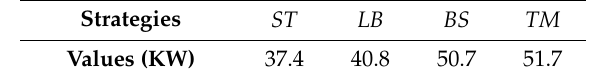
Table 5. Values of actual solar power utilized on a cloudy (rainy) day.